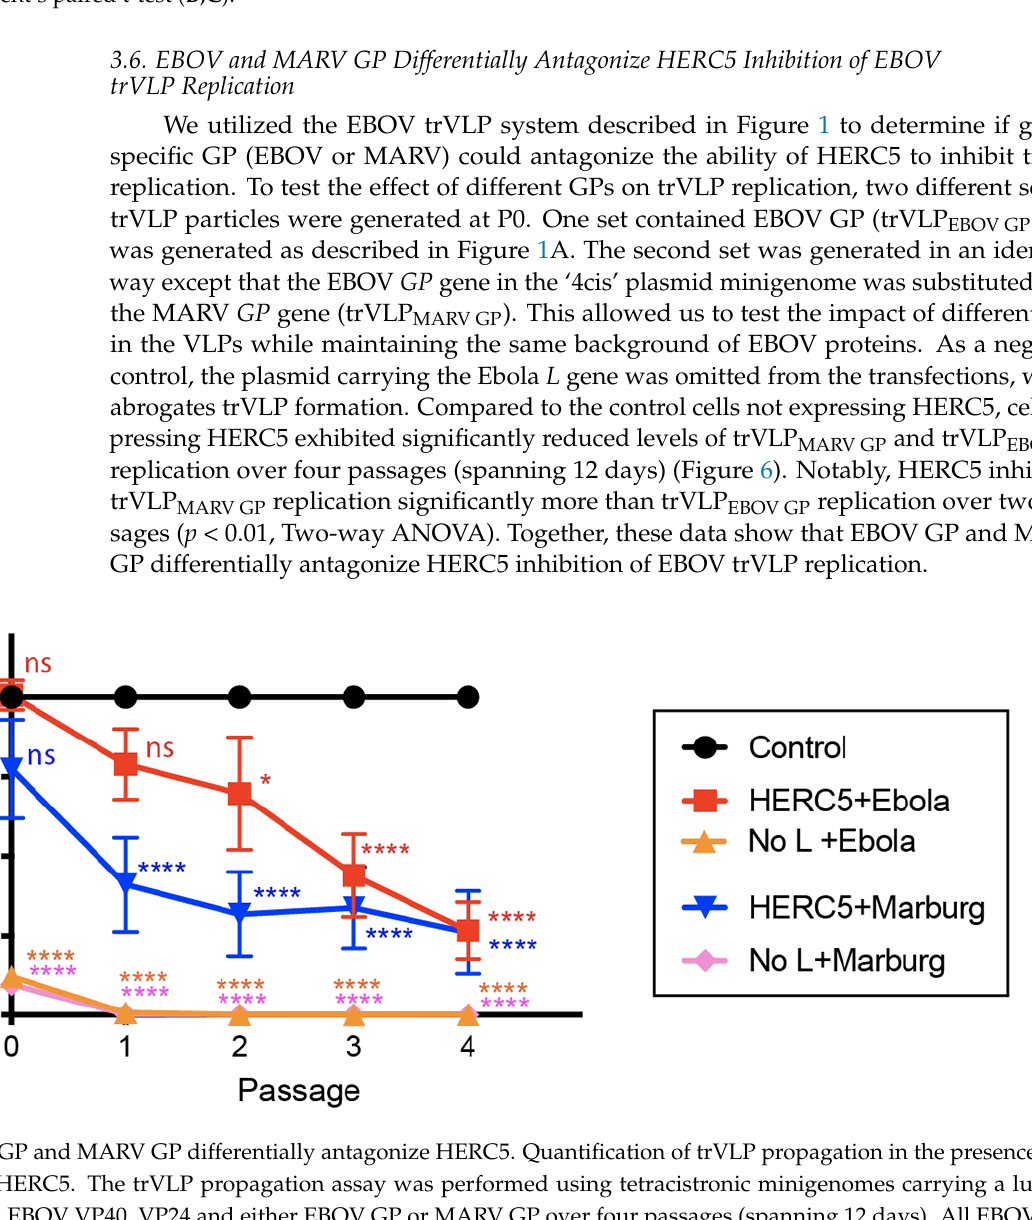
Figure 5. EBOV GP and L antagonize HERC5. 293T cells were co-transfected with plasmids carrying FLAG-tagged VP40 and either empty vector or HERC5 and one plasmid carrying either EBOV VP30, VP35, L NP, GP or VSV-G. Forty-eight hours post-transfection, VP40 mRNA was measured using qPCR ( A ) and VP40 protein levels in cell lysates and VLPs released into supernatant were analyzed by quantitative Western blotting and quantified densitometrically after normalization to GAPDH levels ( B ). ( C ) 293T cells were co-transfected with plasmids carrying FLAG-tagged VP40 and either empty vector or HERC5, and one of EBOV GP (eGP) or MARV GP (mGP). Forty-eight hours post-transfection, VP40 protein levels in cell lysates and VLPs released into the supernatant were analyzed via Western blotting using anti-FLAG and anti-GAPDH. The data shown represent the average (+/- S.E.M.) of three independent experiments. * p < 0.05, ** p < 0.01, *** p < 0.001, **** p < 0.0001, ns (not significant) p > 0.05; One-way ANOVA with Dunnett’s multiple comparisons test compared to the control ( A ); Student’s paired t-test ( B , C ).